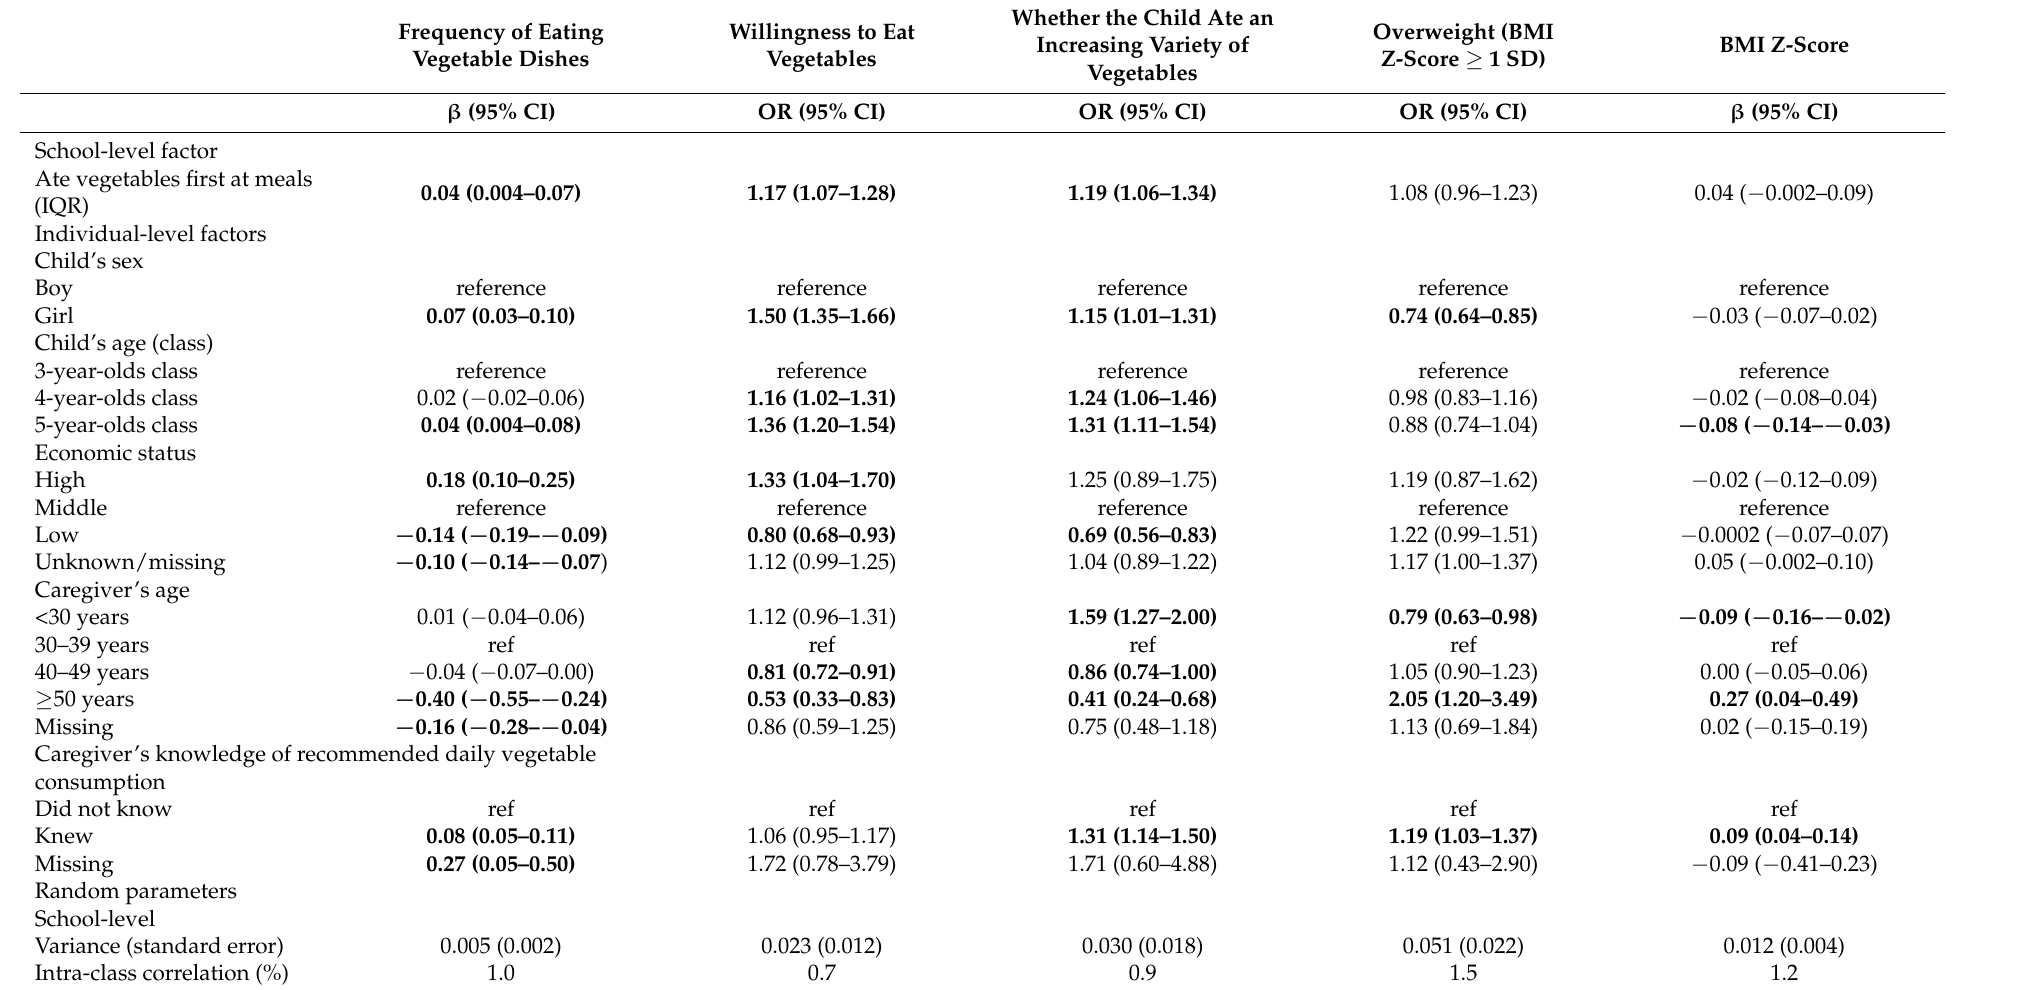
BMI: body mass index; OR: adjusted odds ratio; CI: confidence interval. Boldface indicates statistical significance ( p <